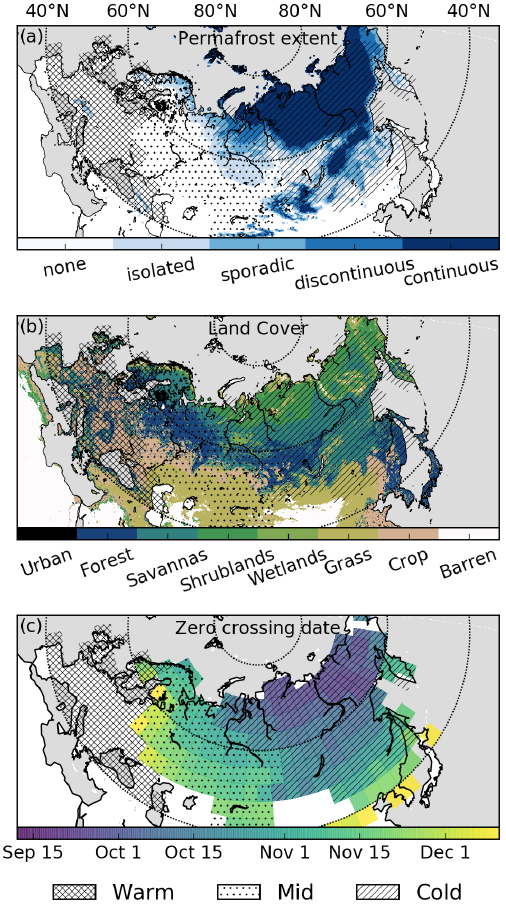
Figure 1. (a) Permafrost extent over 2000–2016 (Obu et al., 2018, 2019). (b) MODIS International Geosphere Biosphere Pro- gramme (IGBP; MOD12C1 v6) land cover for urban areas, for- est (tree cover > 60% and height > 2m), savanna (tree cover 10%–60% and height > 2m), shrublands (woody perennials cover > 10% and height < 2m), grasslands, croplands, and barren land. (c) Zero-crossing date (date when the mean soil temperature drops below 0 ◦ C) for the top 0.5m of soil from the MERRA-2 Land dataset at 4 ◦ × 5 ◦ spatial resolution. Grid cells with no shading do not have a zero-crossing date. Three regions are shown by dif- ferent hatching patterns. The “Warm” (cross hatching) region does not have a zero-crossing date, the “Mid” (dots) region has a zero- crossing date after 27 October, and the “Cold” (diagonal hatching) region has a zero-crossing date before 27 October. Note that some adjustments from these definitions are made so that the regions are contiguous. The Warm, Mid, and Cold regions have land areas of 5 . 66 × 10 6 km 2 , 8 . 66 × 10 6 km 2 , and 12 . 65 × 10 6 km 2 , respectively.